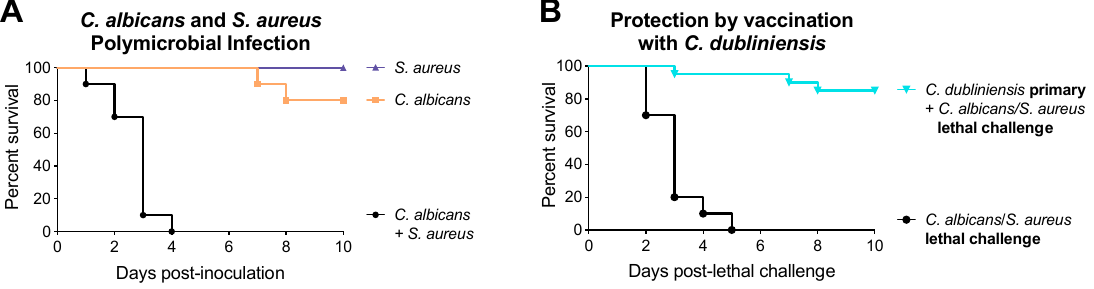
Figure 1. Representative graphs of ( A ) Candida albicans / Staphylococcus aureus synergistic lethality and ( B ) Candida dubliniensis -induced protection. Adapted from [20,21,23].